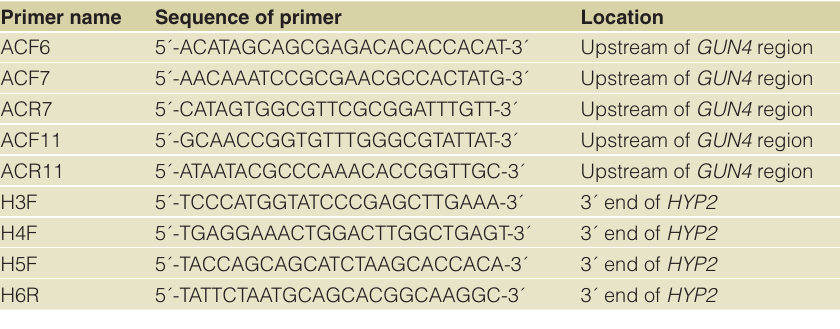
Table 4. List of primers used for transcript analysis of GUN4 and GUN4 neighboring genes in 6F14 . These primers were used to generate the data in Figure 7. The gene loci numbers in Phytozome for the three neighboring genes of GUN4 on chromosome 5 and the control actin gene on chromosome 13 are: